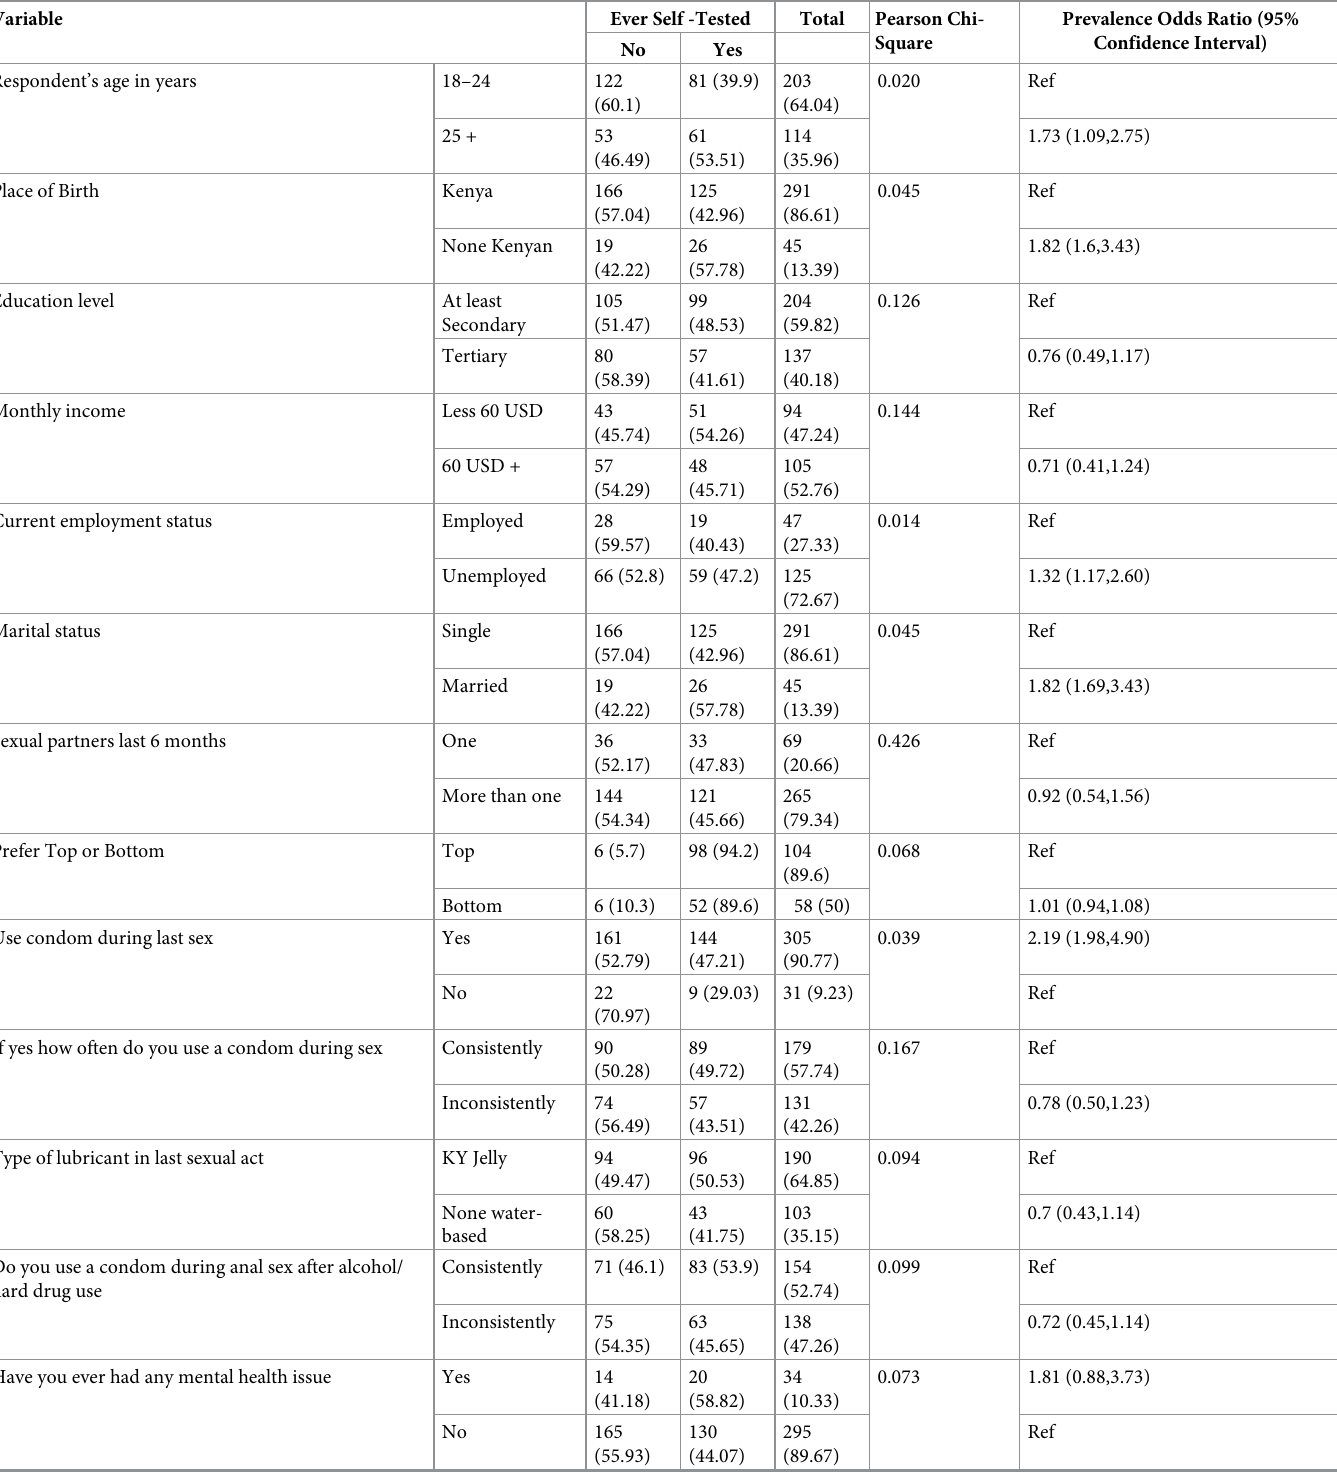
Table 2. Uptake of HIV self -testing & risk